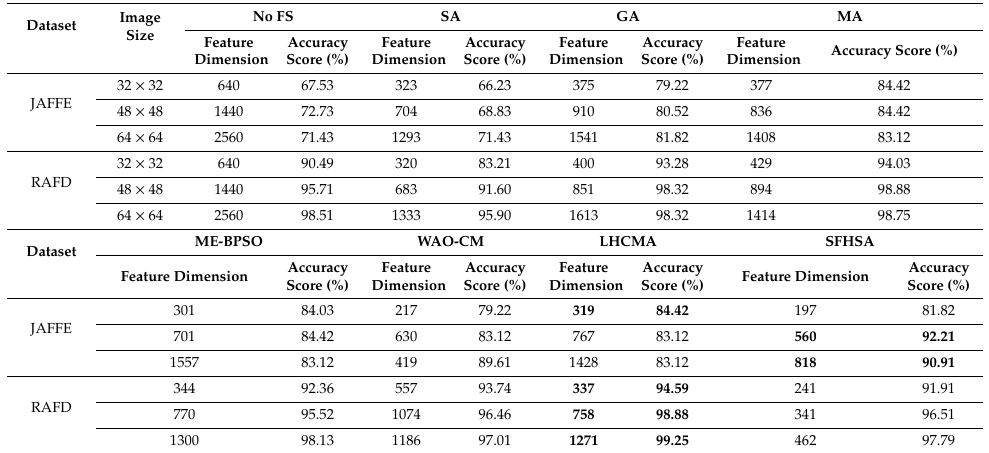
Table 5. Performance of SFHSA with respect to No FS, SA, GA, MA, ME-BPSO, WAO-CM and LHCMA for Gabor filter-based features.